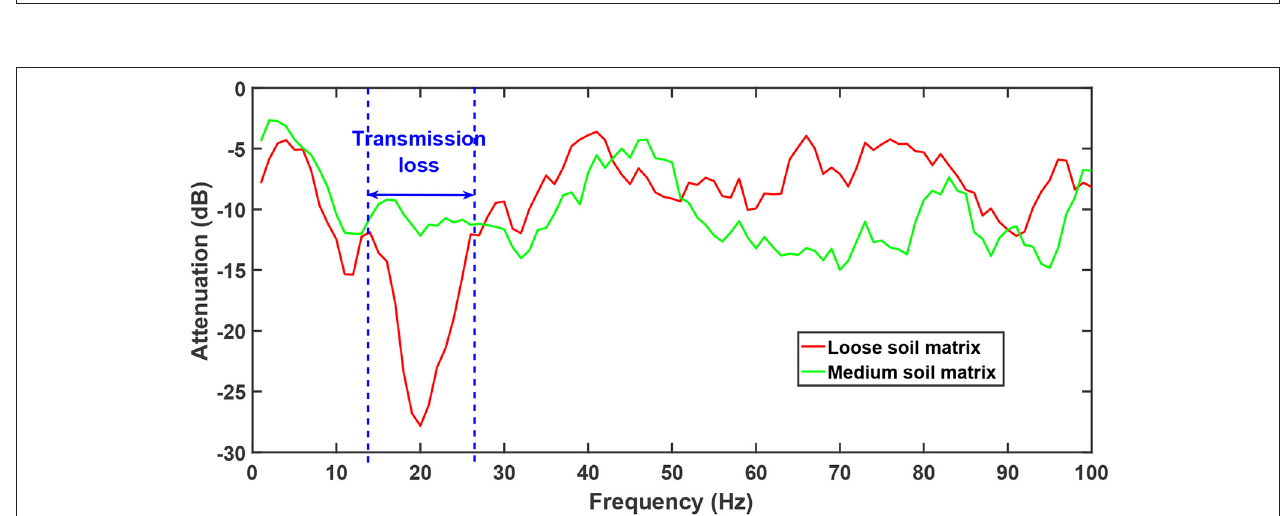
FIGURE 9 | Transmission losses for unclamped concrete inclusions (2 × 2 × 10 m) in very soft soil type 1 (E = 10 MPa, µ = 0.25, and ρ = 1,400 kg / m 3 ) and medium soil (E = 153 MPa, µ = 0.33, and ρ = 1,800 kg / m 3 ) matrix (3 × 3 × 10 m) corresponding to Figure 8 . The substitution ratio is kept same, i.e., 0.445. Notably, square concrete inclusions in very soft soil type 1 show attenuation in the bandgap range, i.e., 18.45–22.36 Hz.